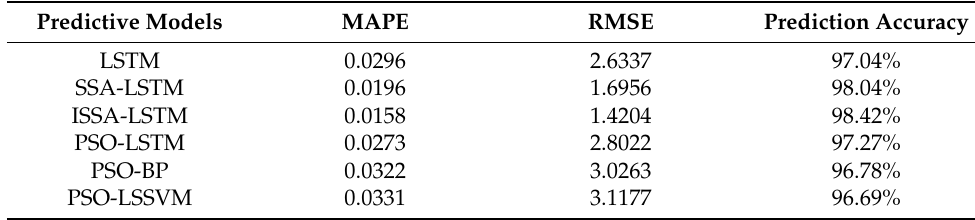
Table 8. Model-prediction index and accuracy-calculation results. Predictive